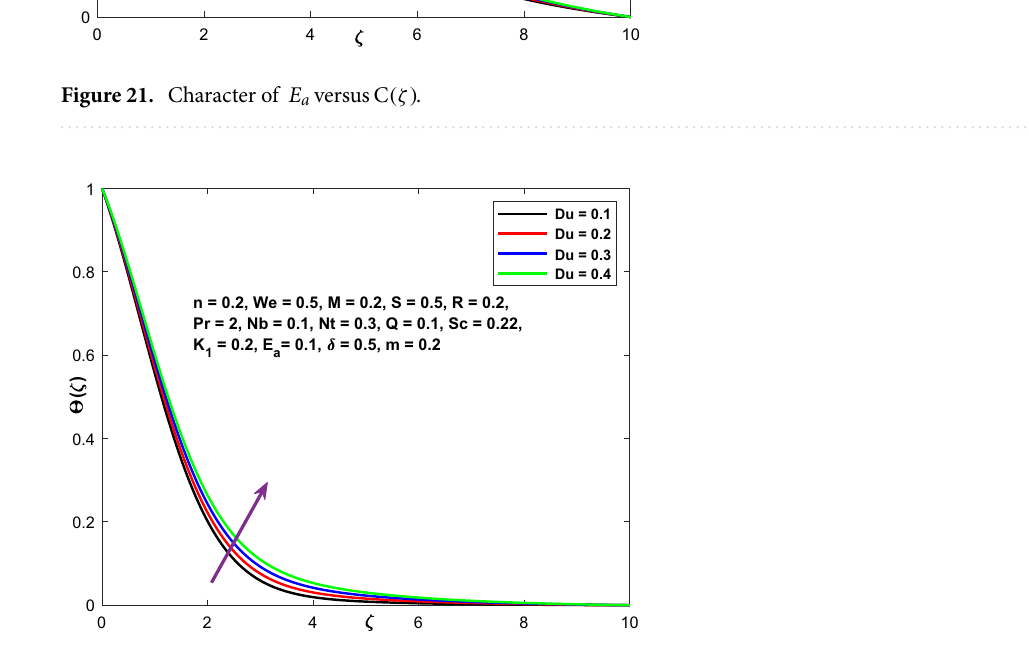
Figure 22. Character of E a versus C (ζ)